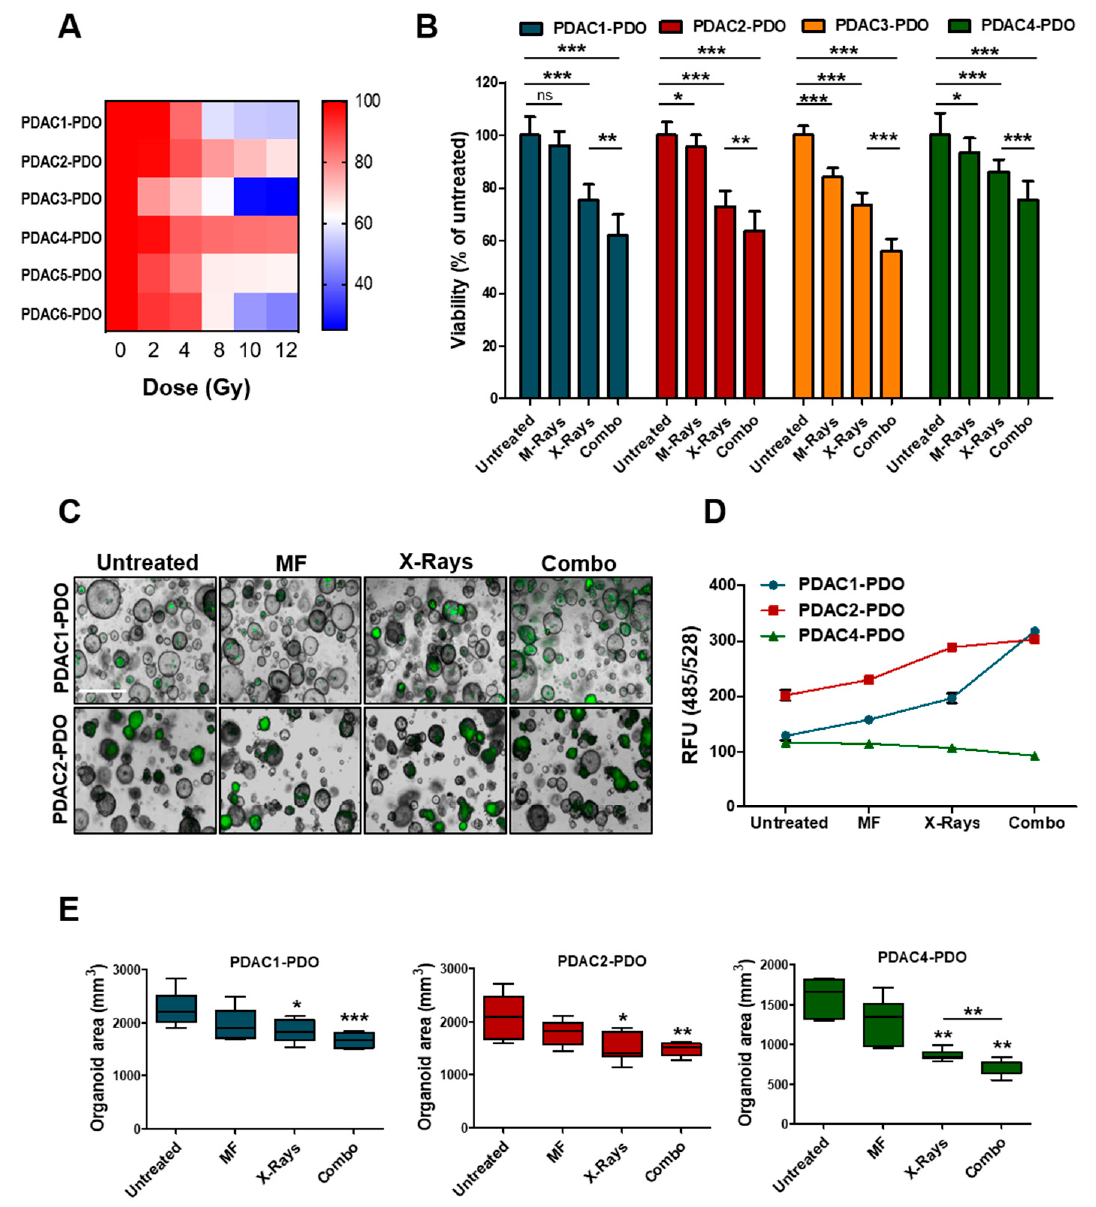
Figure 3. Response of PDAC-PDOs to Irradiation. ( A ) Heat-map showing dose-response to irradiation of six different PDAC-PDO cultures. Viability of each organoid culture as mean of five technical replicates. ( B ) Bar plots showing changes in cell viability after 6 Gy X-Rays in four representative PDAC-PDOs. Viability is reported as means of three independent experiments. ( C ) Representative images of organoids after 6 Gy X-Rays and MF, alone and / or in combination, compared to control. Apoptotic organoids are visualized as green structures. Scale bar, 100 µ m. ( D ) Quantification of green fluorescent signal (relative fluorescence units, RFU) in the 3 PDAC-PDO lines from C; data are displayed as mean ± SD. ( E ) Changes in oganoids size after MF, and 6 Gy X-Rays treatment, alone and / or in combination, compared to untreated organoids in the three organoid lines. Organoids size data shown are means from two independent experiments. *, p > 0.05; **, p < 0.01; ***, p < 0.001 by student’ t